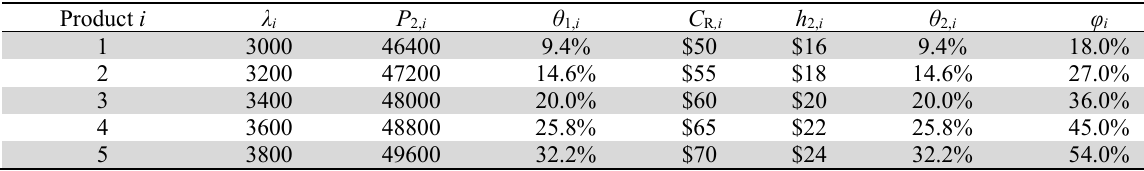
Parameters’ values of the same problem under a single stage production scheme -2 Product i